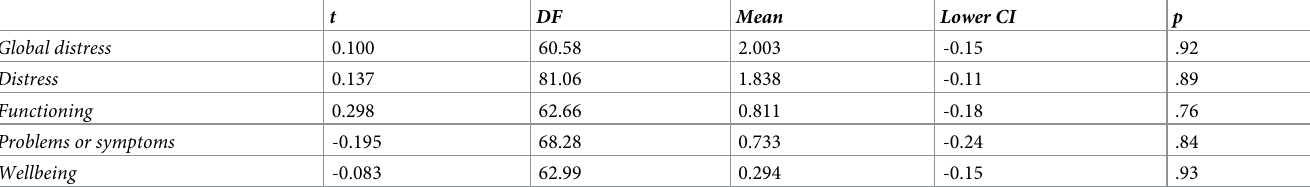
Table 4. Results of independent samples t-tests on CORE-OM change scores for test and control conditions in Study